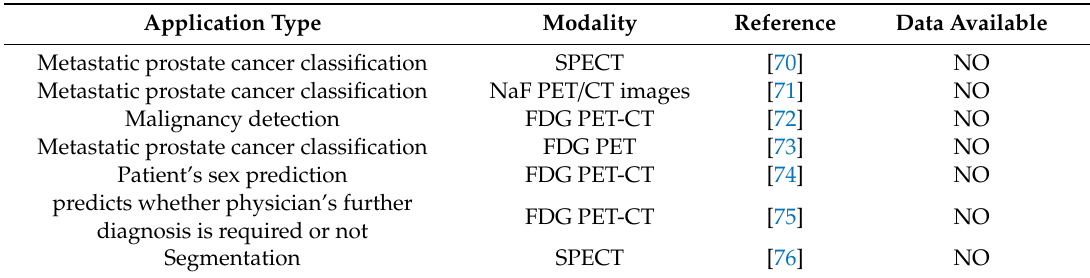
Table 2. Summary of CNNs applied in whole-body scans for bone metastasis classification in nuclear medicine